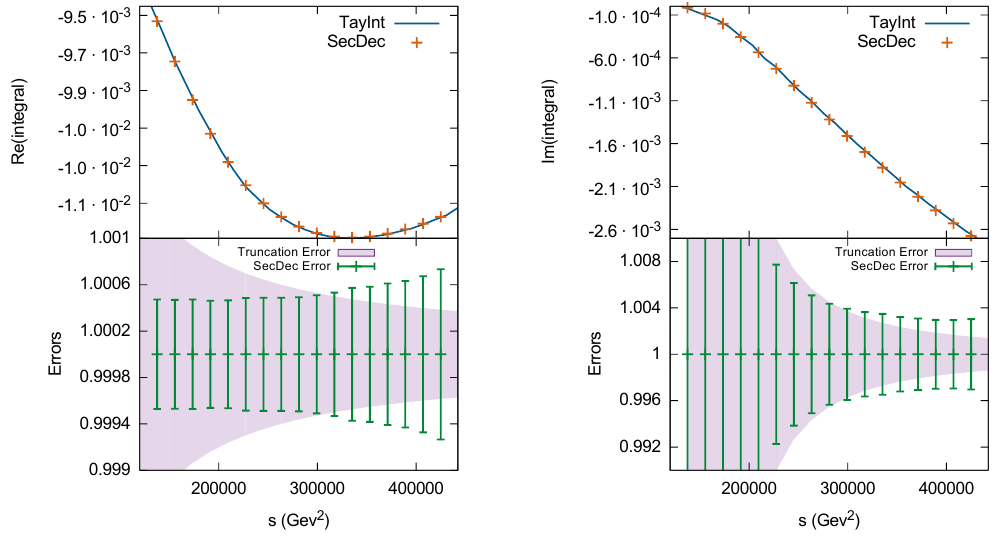
Figure 21 . The I39 Integral calculated at O ( (cid:15) 2 ) with a fourth-order series expansion. The scale s is over the 4 m 2 threshold, with u = (cid:0) 59858GeV 2 , m 2 = 1 p 1 plots show the relative TayInt and SecDec uncertainties,